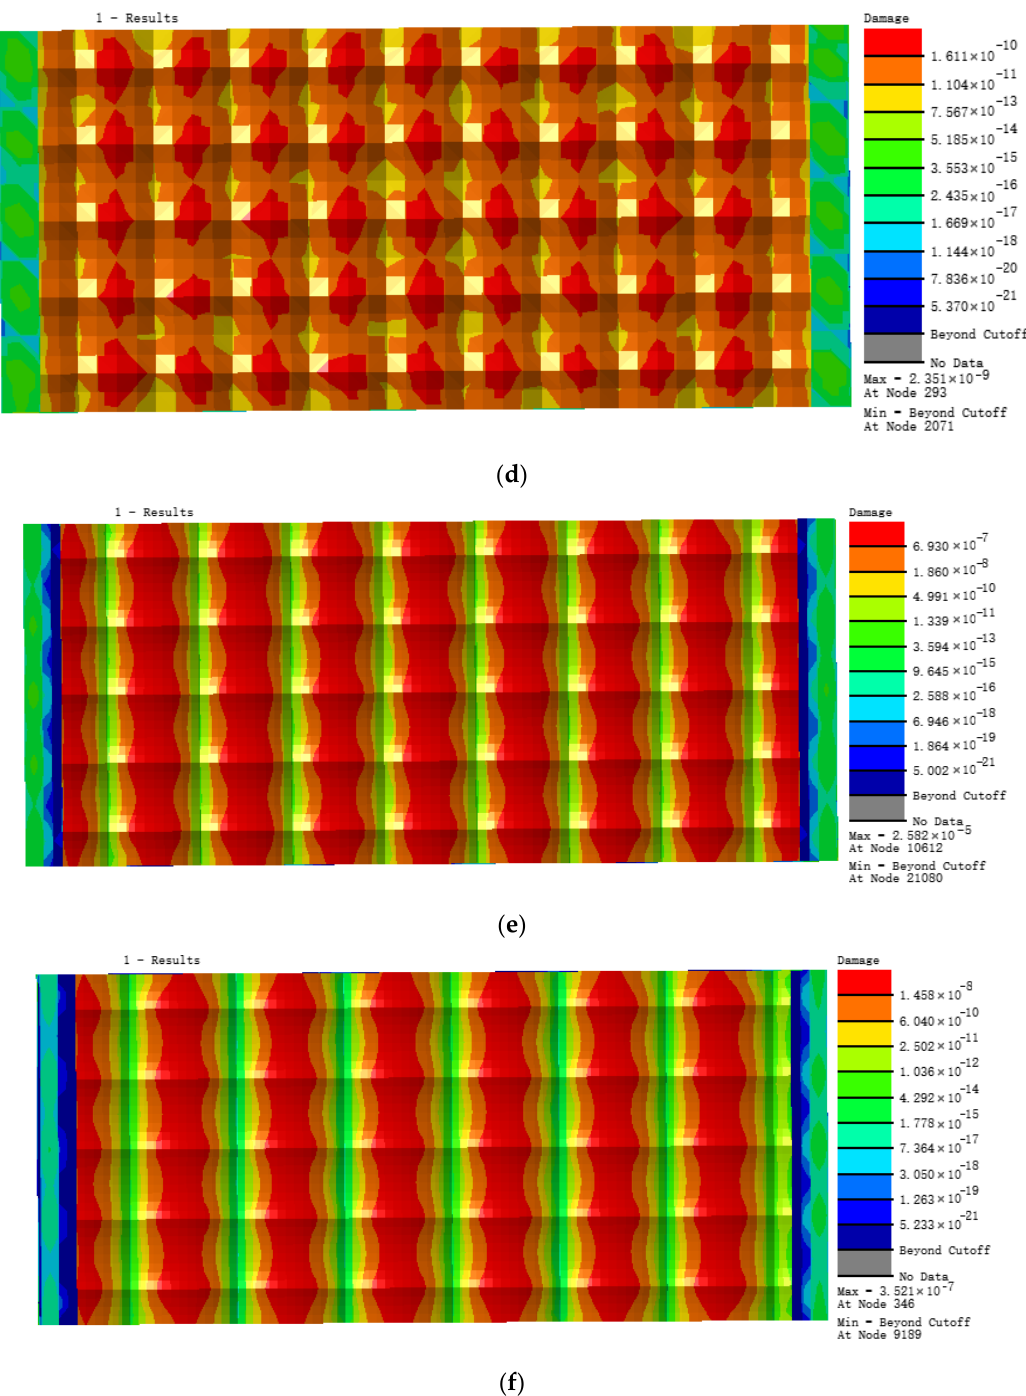
Figure 13. Nephograms of fatigue damage. ( a ) F1 model; ( b ) F2 model; ( c ) F3 model; ( d ) F4 model; ( f ) F5 model; ( e ) F6 model.